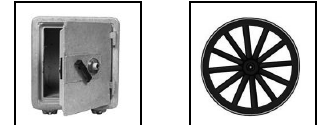
Figura 3 . Par de codi fi cação do teste de reconhecimento associativo.